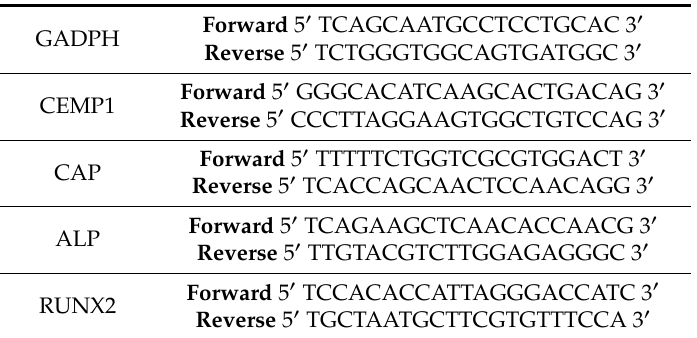
Table 2. Primers for qPCR